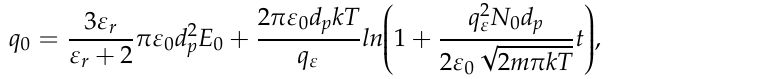
Figure 2. Simplified scheme of composition and principle of charged room.